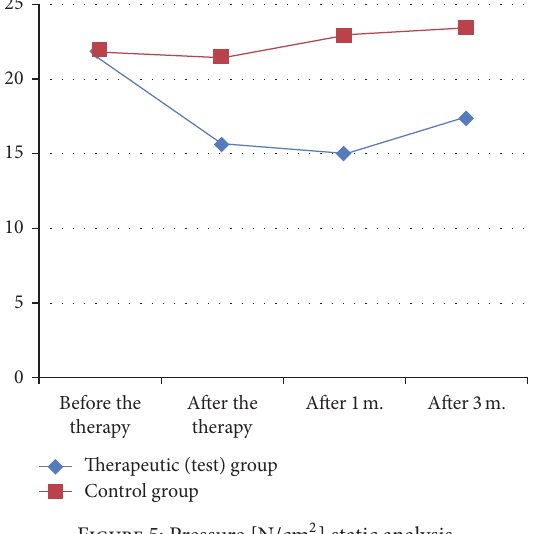
Figure 5: Pressure [N/cm 2 ] static analysis.